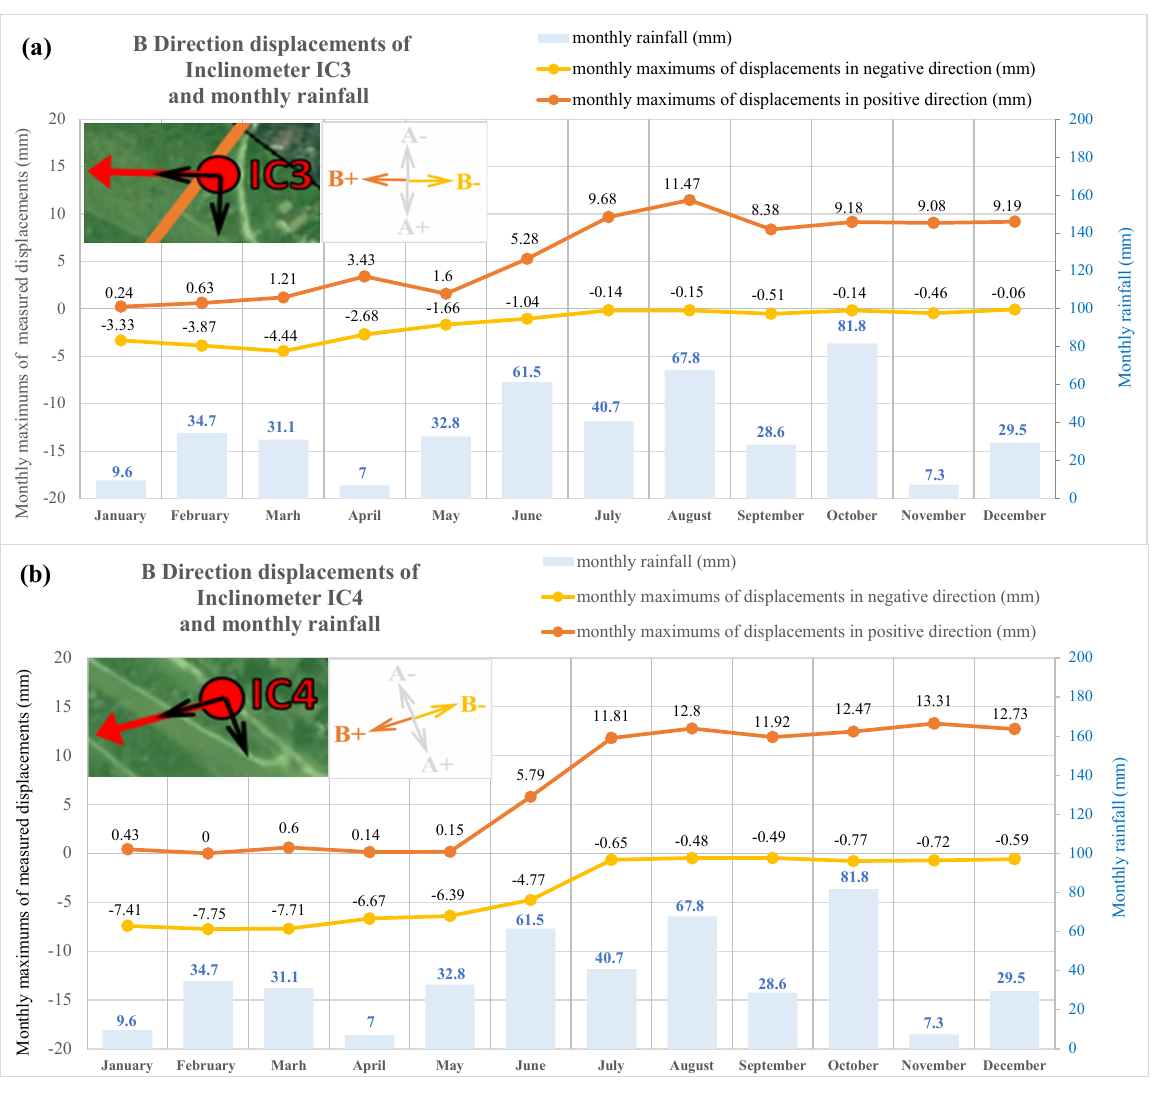
Figure 8. Graphs of monthly maximum displacements measured by inclinometers and monthly rainfall ( a ) B direction displacements of inclinometer IC3 and monthly rainfall ( b ) B direction dis- placements of inclinometer IC4 and monthly rainfall.